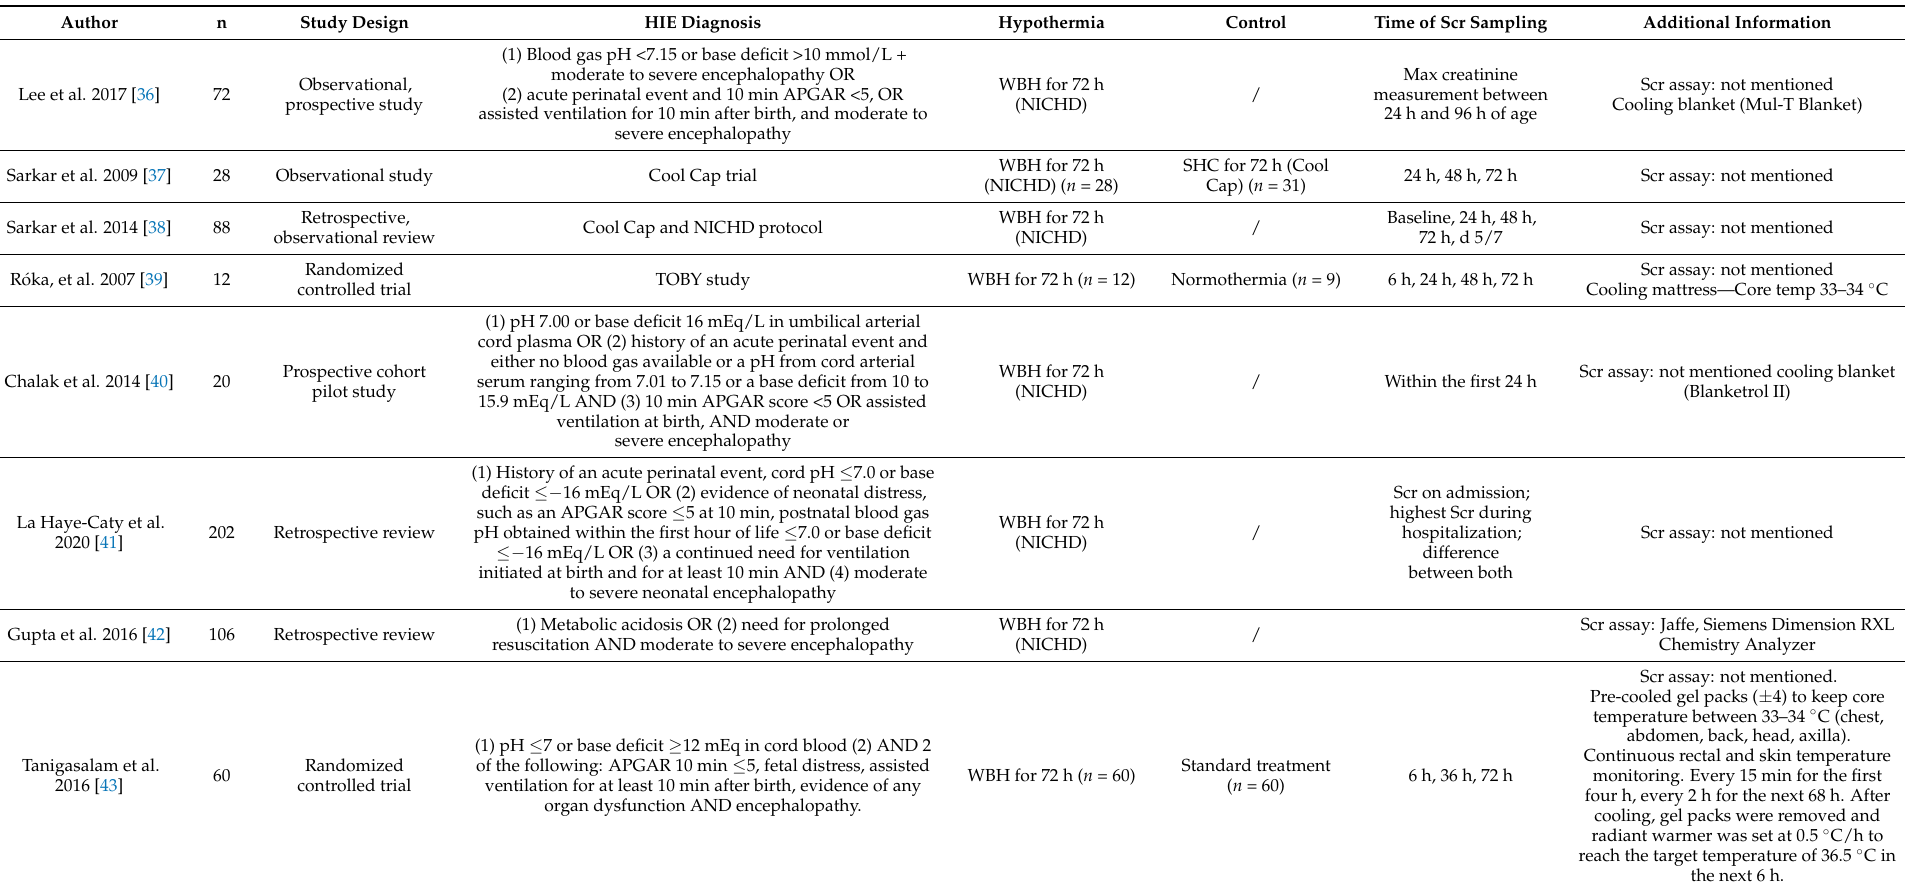
Table 2. Study characteristics of the 13 studies retained in the systematic review (HIE: hypoxic-ischemic event; WBH: whole body hypothermia; Scr: serum creatinine; NICHD: National Institute of Child Health and Human Development; SHC: selective head cooling; TOBY: Total Body Hypothermia trial). The group of interest was the asphyxia + hypothermia group, only when based on WBH